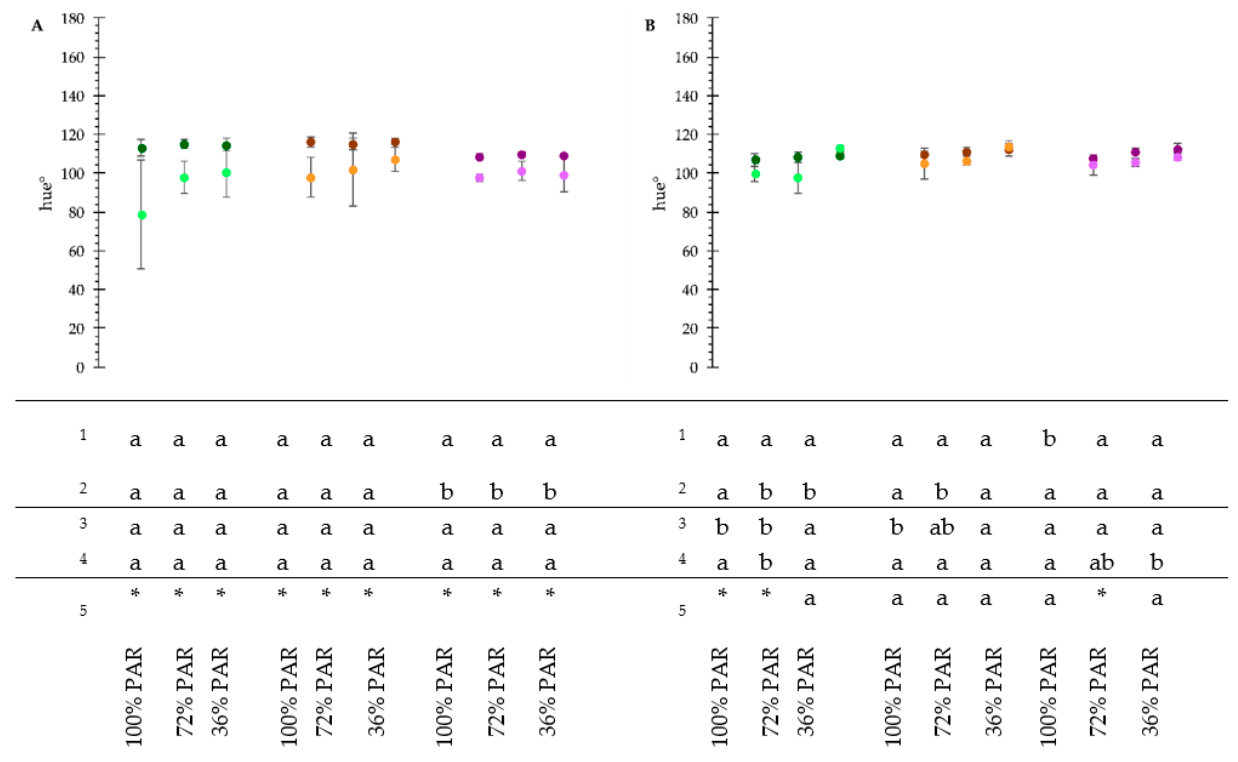
Figure 7. Hue angle of three different H. macrophylla subsp. serrata cultivars (green: ‘Oamacha’, orange: ’Odoriko Amacha’, purple: ‘Amagi Amacha’) at first (dark coloring) and last (light coloring) day of measurements in two cultivation periods (( A ): 2018; ( B ): 2019). Shading regimes are indicated by PAR values (100% PAR: no shade, 72% PAR: partial shade, 36% PAR: full shade). Significant differences are highlighted by letters. Differences within cultivar at first (1) and last (3) day of measurements and differences within light regime at first (2) and last day (4) of measurements were calculated by ANOVA and Tukey HSD (n = 5, α = 0.05). Differences between first and last day of each treatment (5) were calculated by Student’s t-test with significant differences marked by asterisk (*). ANOVA tables can be found in the Supplementary Materials Table S6.